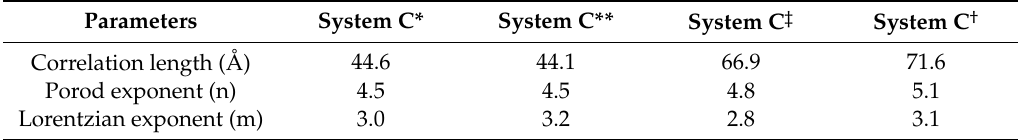
Table 5. Correlation length, Porod, and Lorentz